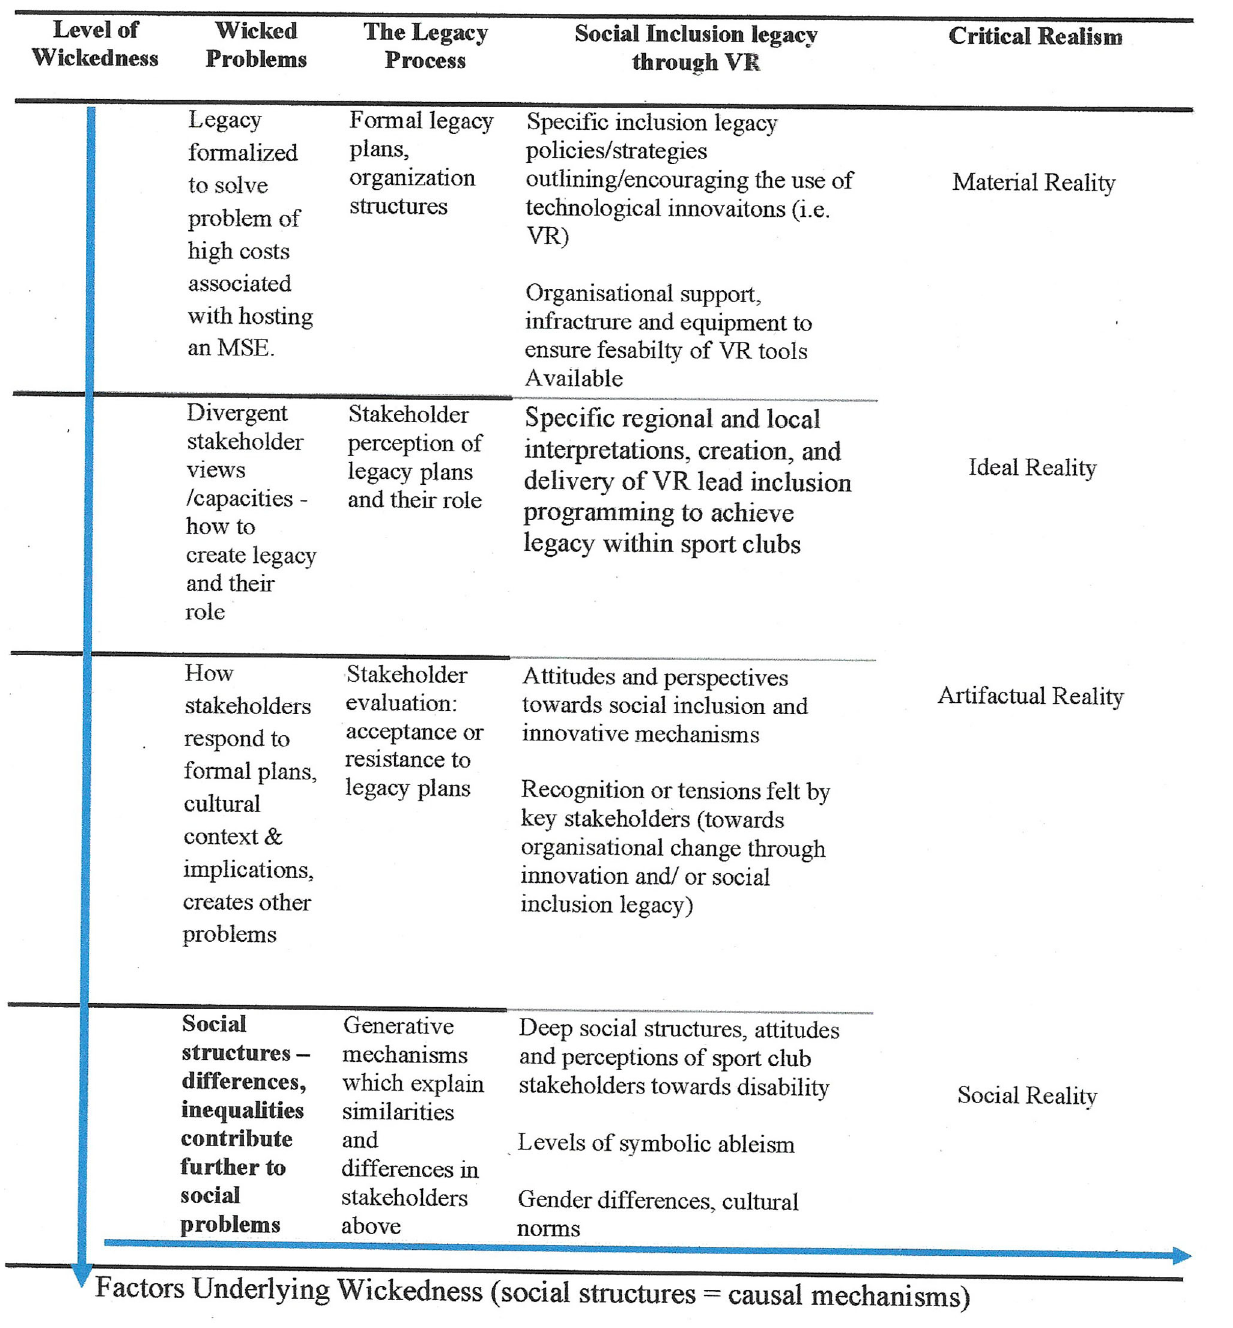
FIGURE 1 | Social inclusion legacy delivery as a “wicked problem”: A critical realist perspective. Factors underlying wickedness (social structures = causal mechanisms). Adapted from Byers et al.’s (2020, p.